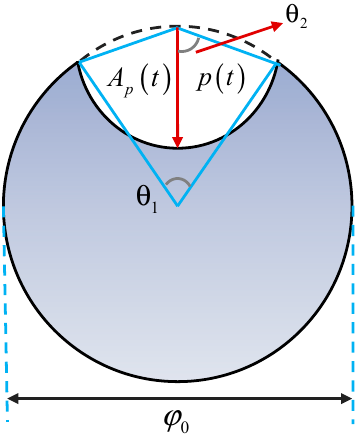
( ) ( ) Figure 4. Pit configuration: p ( t ) : the pitting depth; A p ( t ) : the reduced area due to pitting corrosion; θ 1 Figure 4. Pit configuration: A t : the reduced area due to pitting p t : the pitting depth; p and θ 2 : the angle parameters; ϕ 0 : the diameter of the steel θ and θ : the angle parameters ; ϕ : the diameter of the steel bar. corrosion; 1 2 0